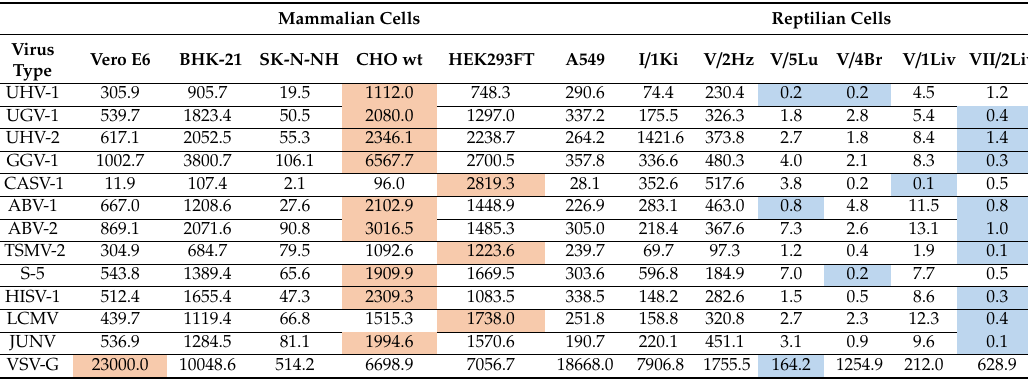
Figure 3. Control infections on all cell lines with naked VSV (VSV-G0) and VSV pseudotyped with its own GP (VSV-G). The X-axes represent the di ff erent cells lines and the Y-axis the number of infected cells (left) or the percentage of cells infected (right). The values represent the average of four measurements, and the error bars show standard deviation. White bars represent mammalian and grey bars reptilian cell lines. ( A ) Infection e ffi ciency of VSV-G in mammalian (white bars) and reptilian (grey bars) cell lines. ( B ) Infection e ffi ciency of VSV-G0 in mammalian (white bars) and reptilian (grey bars) cell lines. Opera Phenix high content image screening system served to quantify the infected cells based on eGFP expression and staining of nuclei with Hoechst 33342. Table 1. Infectivity of the pseudotyped viruses in mammalian and reptilian cell lines. The infectivity values are the average of quadruplicates and expressed in 1000 FFFU / mL. For each virus, light red highlights the cell line with the highest and light blue the cell line(s) with the lowest